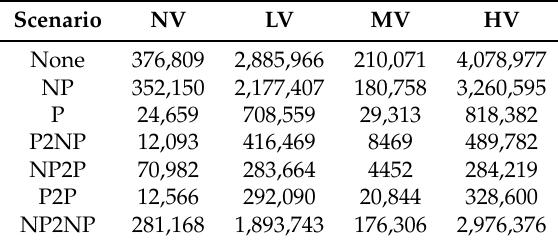
Table 3. Number of training samples for each vegetation state and precipitation scenario. NV, No to marginal Vegetation; LV, Low V; MV, Medium V; HV, High V.